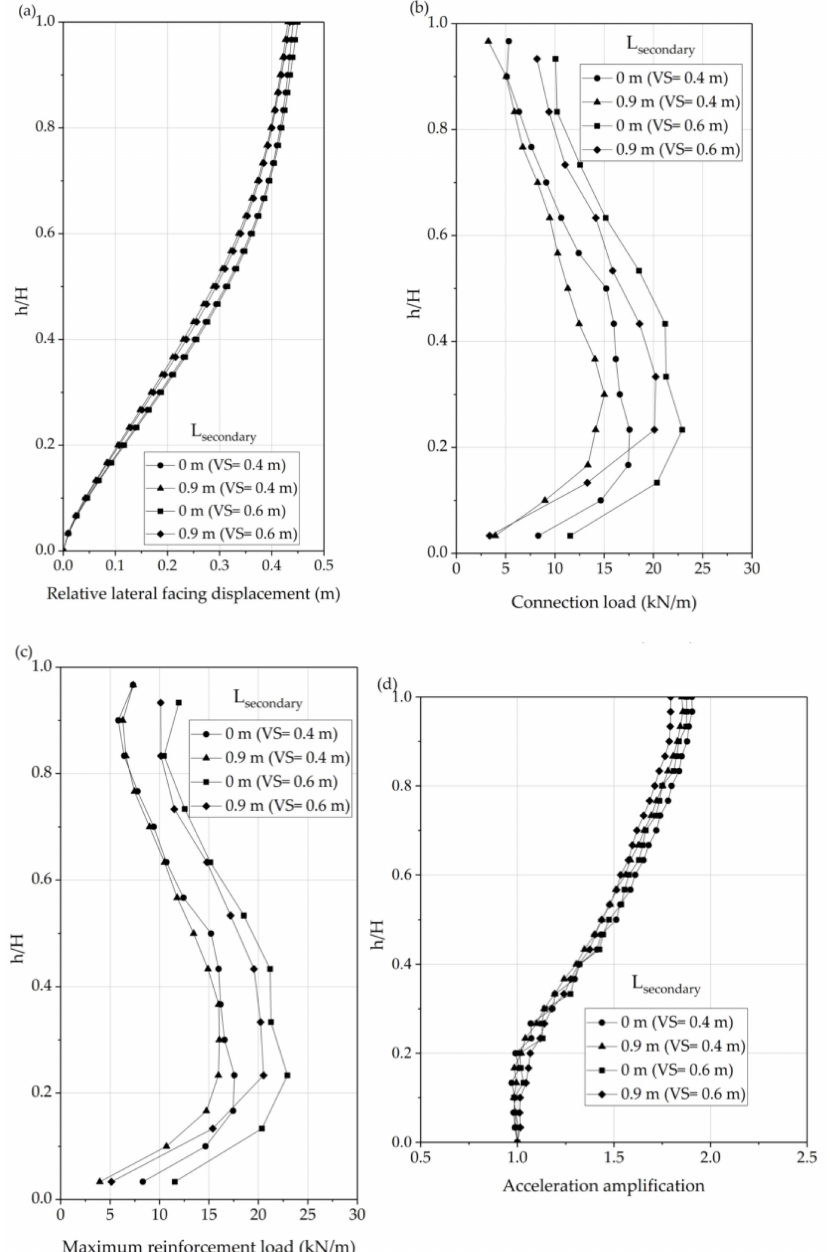
Figure 18. The e ff ect of vertical spacing on ( a ) the relative lateral displacement; ( b ) connection load; ( c ) maximum reinforcement load; ( d ) and acceleration amplification of the wall with and without secondary